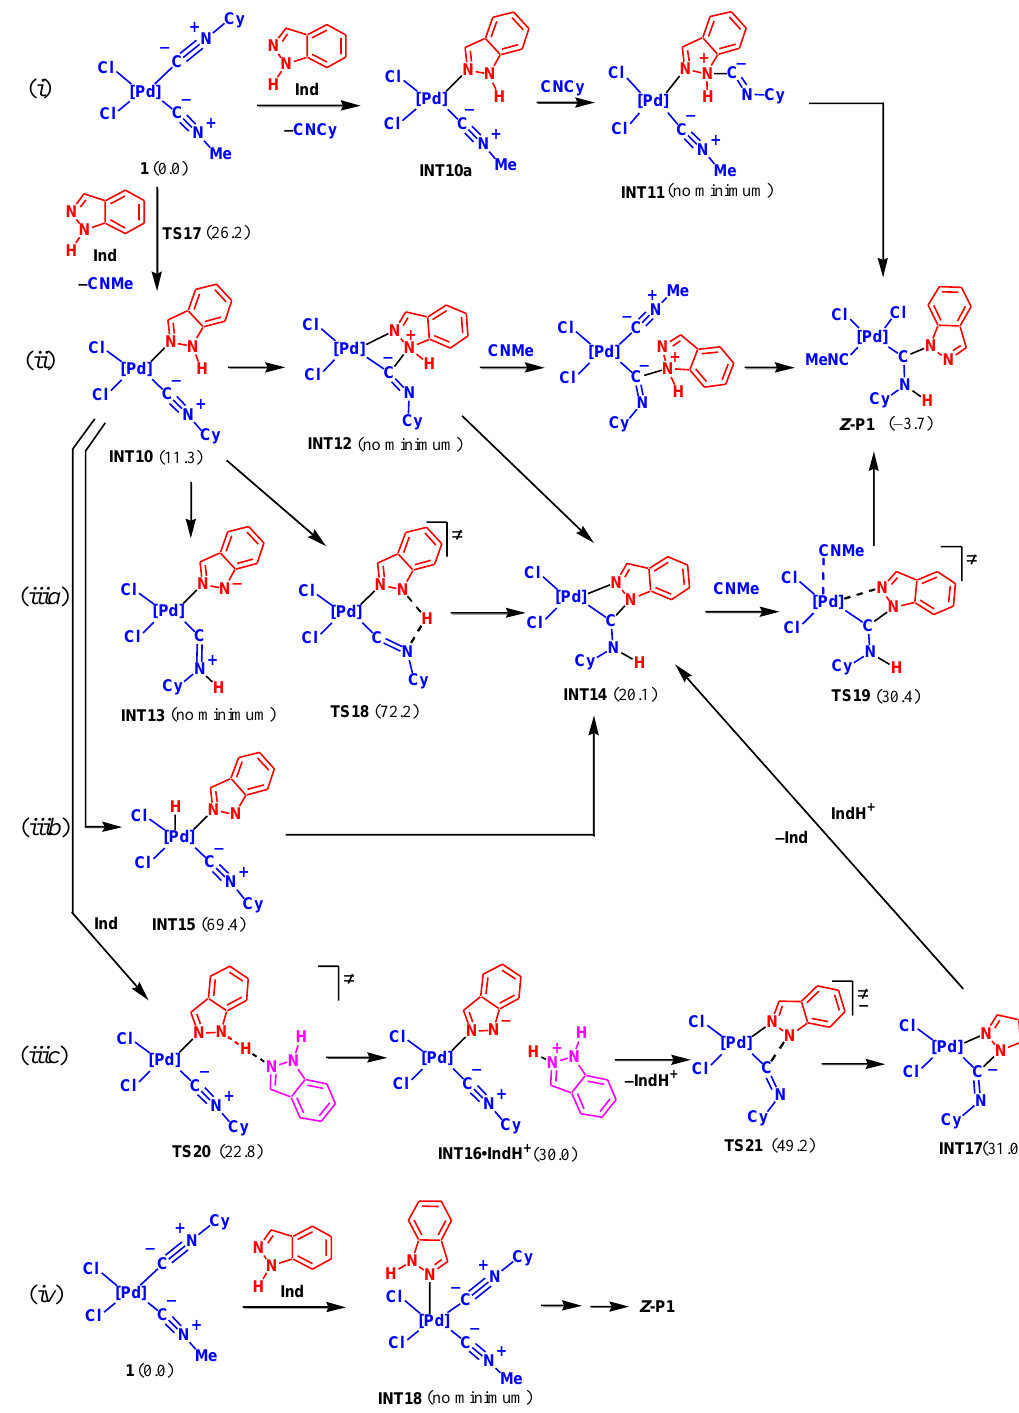
Scheme 9. Mechanisms of NA of indazole to 1 based on the coordinated indazole (Gibbs free energies are indicated in kcal/mol relative to 1 + Ind).